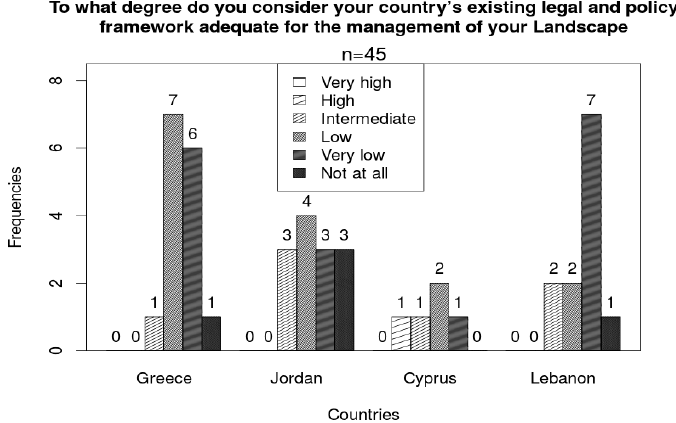
Figure 5. Frequencies of answers to the question “To what degree do you consider your country’s existing legal and policy framework adequate for the management of your (region’s/country’s) landscape?” by country of residence.